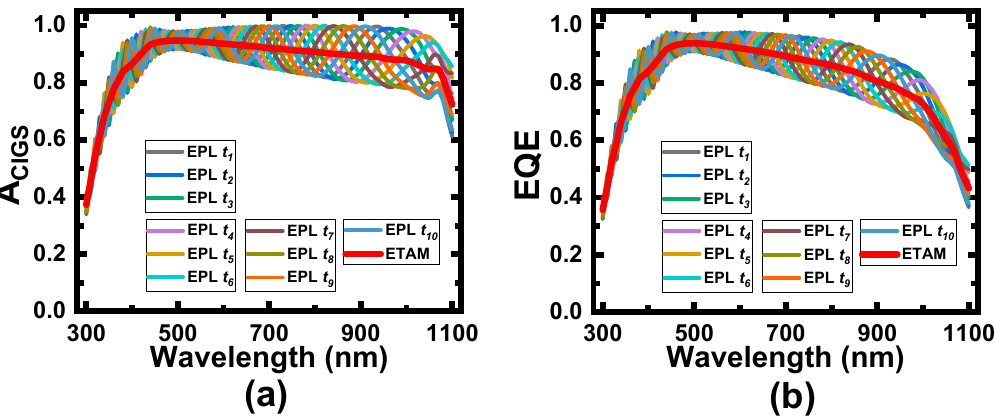
Figure 8. EPL-thickness dependence of ( a ) absorptivity in the CIGS absorber layer A CIGS ( λ , t b ) and ( b ) external quantum efficiency ( EQE). ETAM-applied calculation results were obtained by averaging 10 coherent calculation results over the equispaced phase thicknesses.